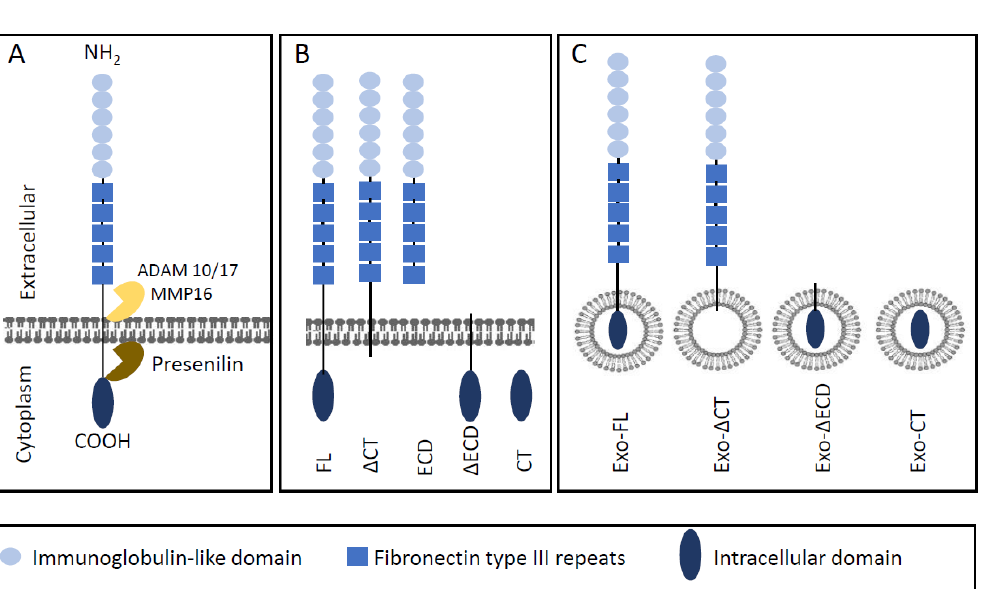
Figure 2. L1CAM cleavage and nomenclature of L1CAM forms discussed in this review. ( A ) Structure of L1CAM including main cleavage sites. ADAM: A Disintegrin and metalloproteinase domain-containing protein. MMP: matrix metalloprotease. ( B ) Full-length L1CAM (FL) and forms resulting from proteolytic cleavage. ΔCT lacks the C -terminal domain, NT represents the soluble N-terminal domain, ΔNT lacks the N -terminal domain, CT represents the cytosolic C-terminal cleavage product. ( C ) Shows exosomal forms (Exo) corresponding with the full-length or proteolytic cleavage forms indicated in B.